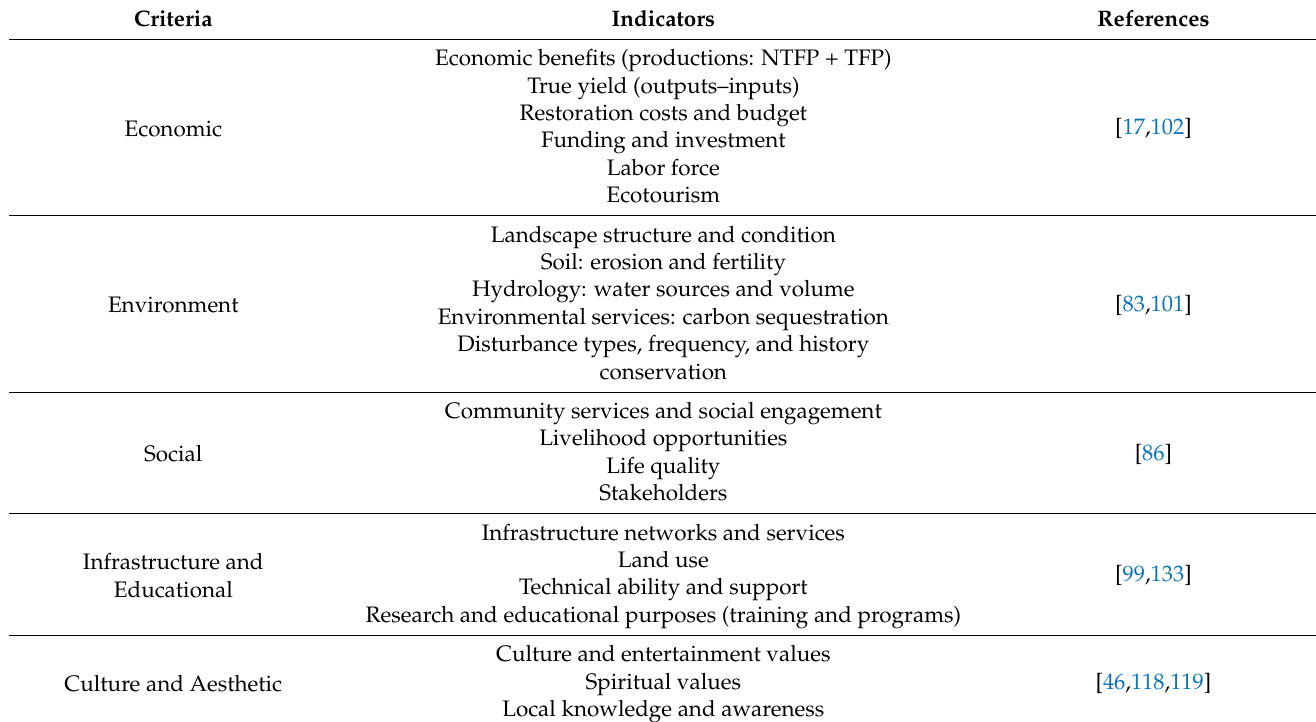
Table 3. Criteria and indicators for inclusion in the comprehensive framework for post-forest fire